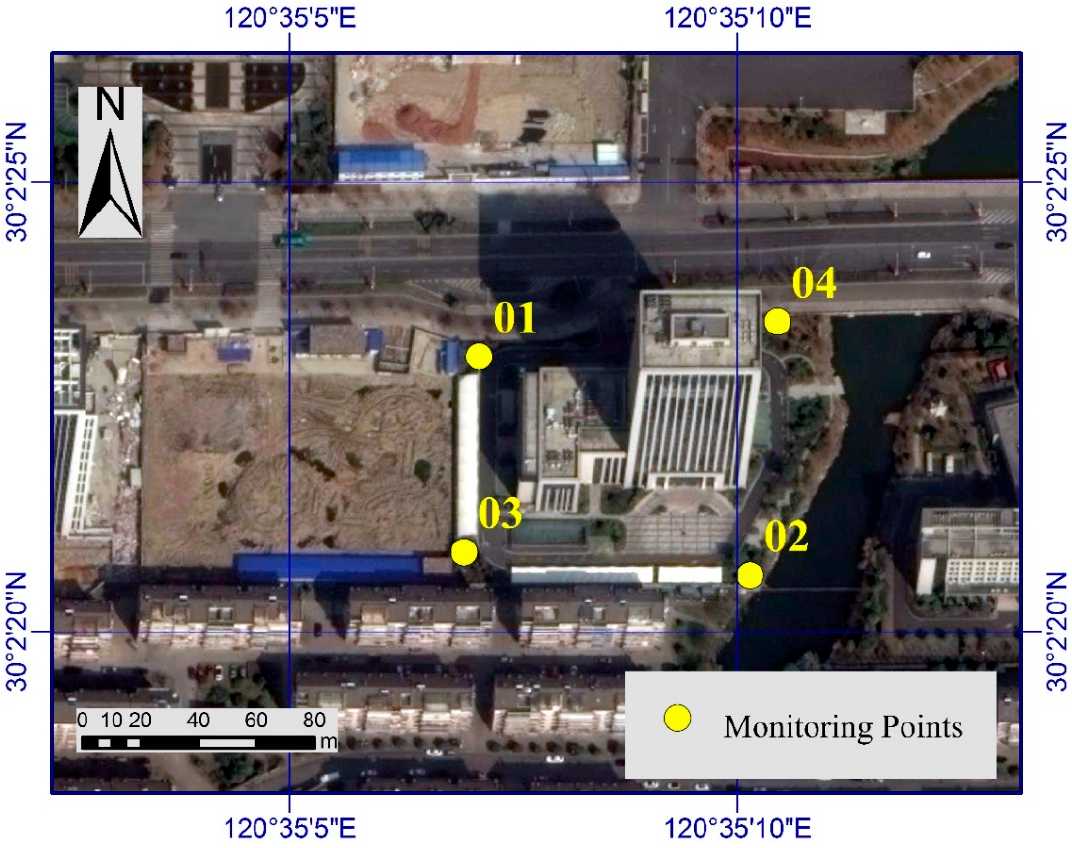
Figure 5. Distribution of monitoring points. Table 3. Basic situation of monitoring points.